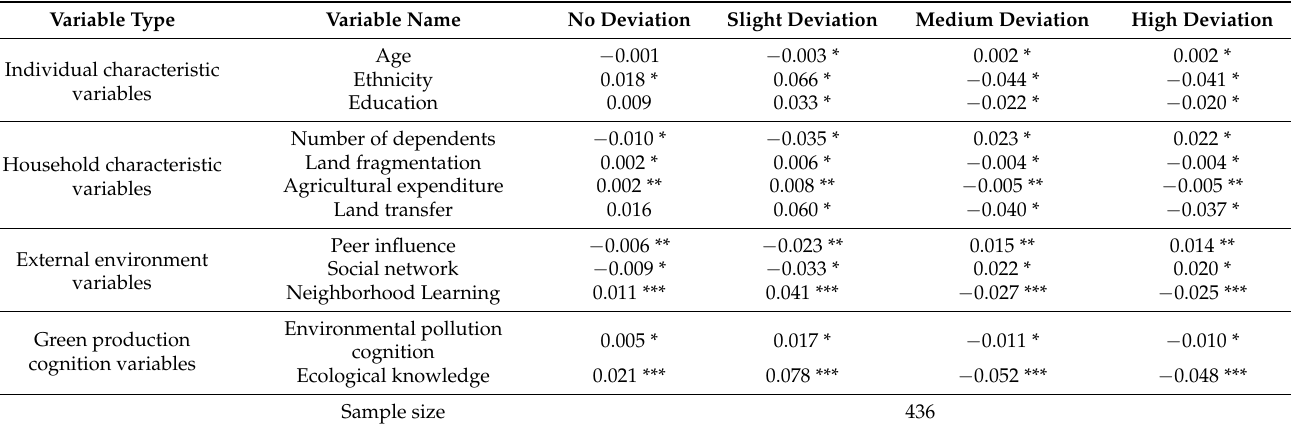
Table 5. Marginal effect analysis